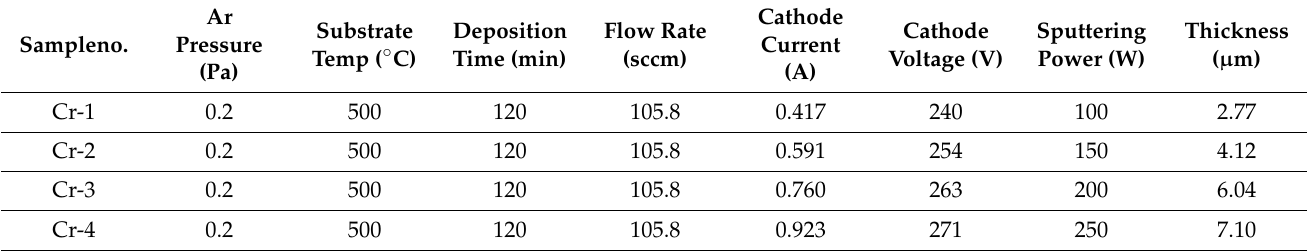
Table 1. Deposition parameters for Cr